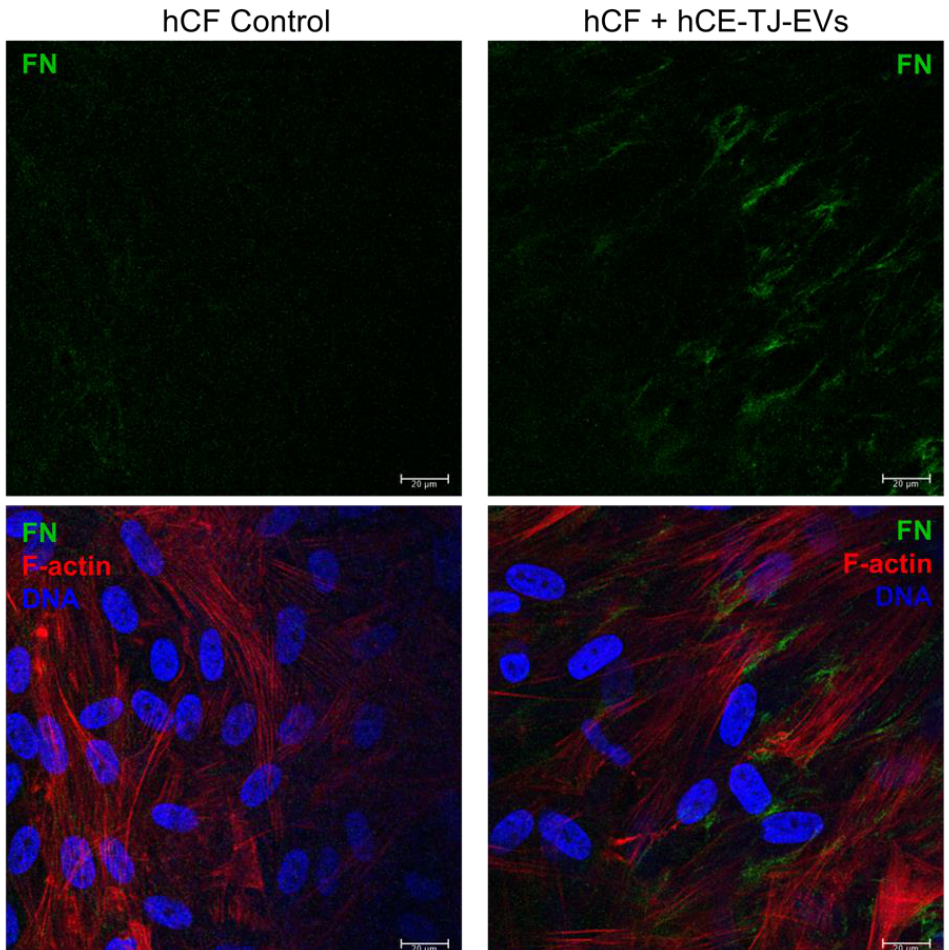
Figure 8. Increased fibronectin localization in hCF constructs with hCE-TJ-derived EV treatment at 3 days post-stimulation. Representative images based on n = 3. Fibronectin (FN) = green; phalloidin (F-actin) = red; Nuclei (DNA) = blue. Scale bars = 20 μm .